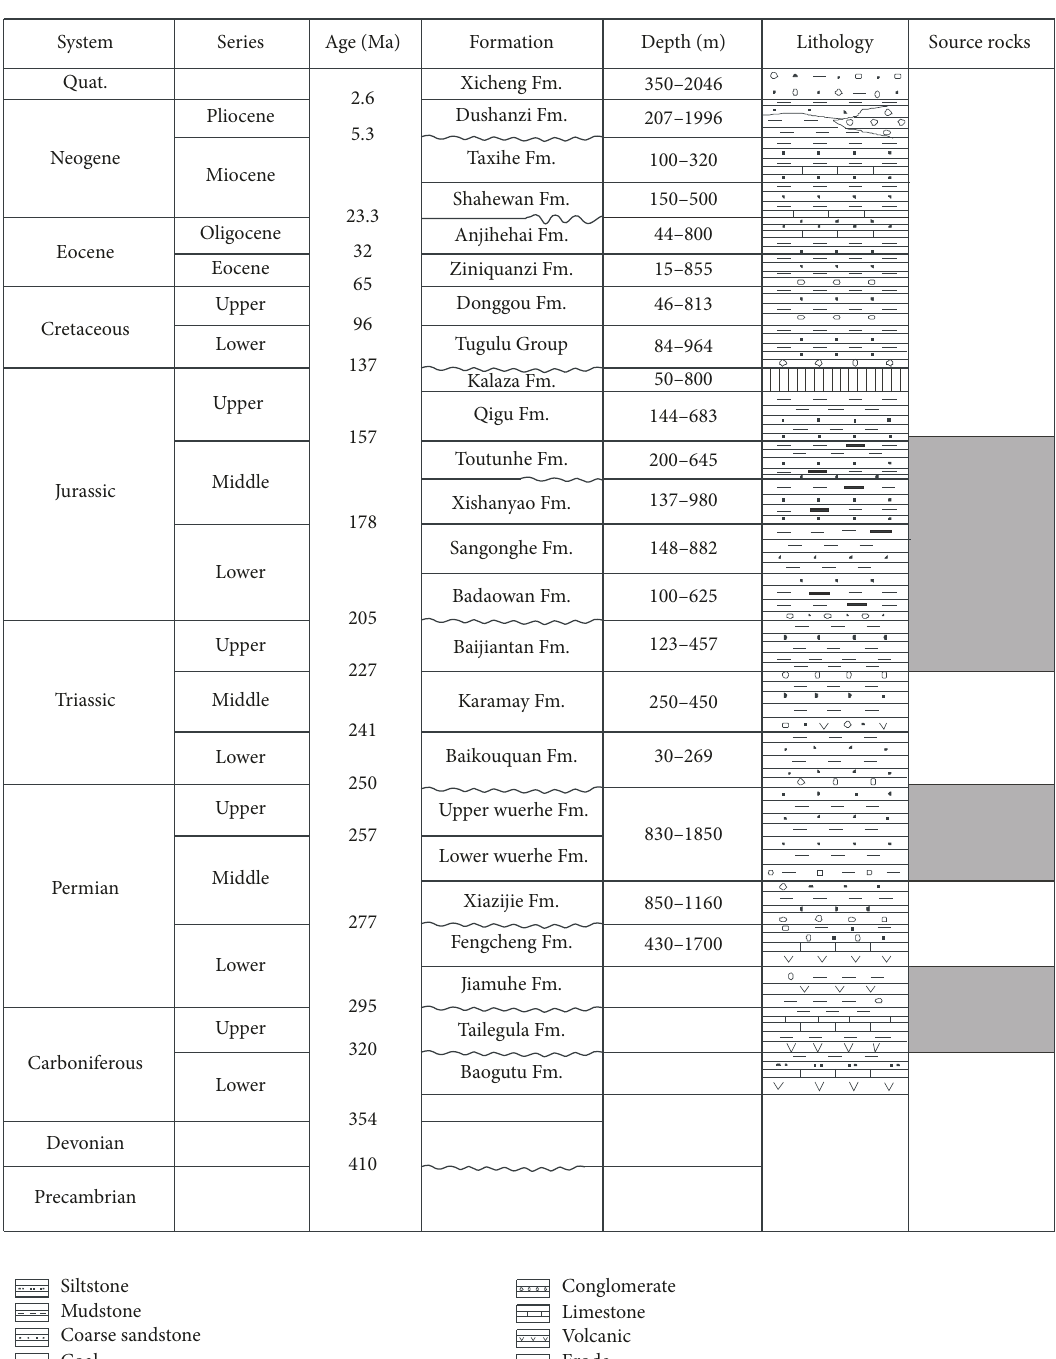
Figure 2: Stratigraphic column and correlation of stratum in the center of Junggar Basin (2002).